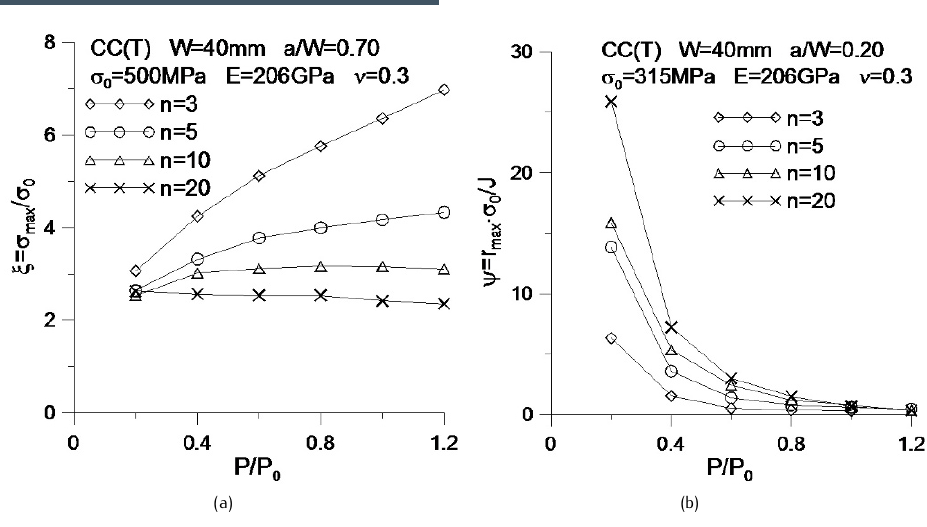
Figure 11. a) The influence of the work hardening exponent on maximum opening stress value σ MPa; (b) The influence of the work hardening exponent on normalized location of the maximum opening stress near crack σ 0 = 500 tip ψ = r max · σ /J for CC(T) specimen – a/W = 0 . 20 , σ 0